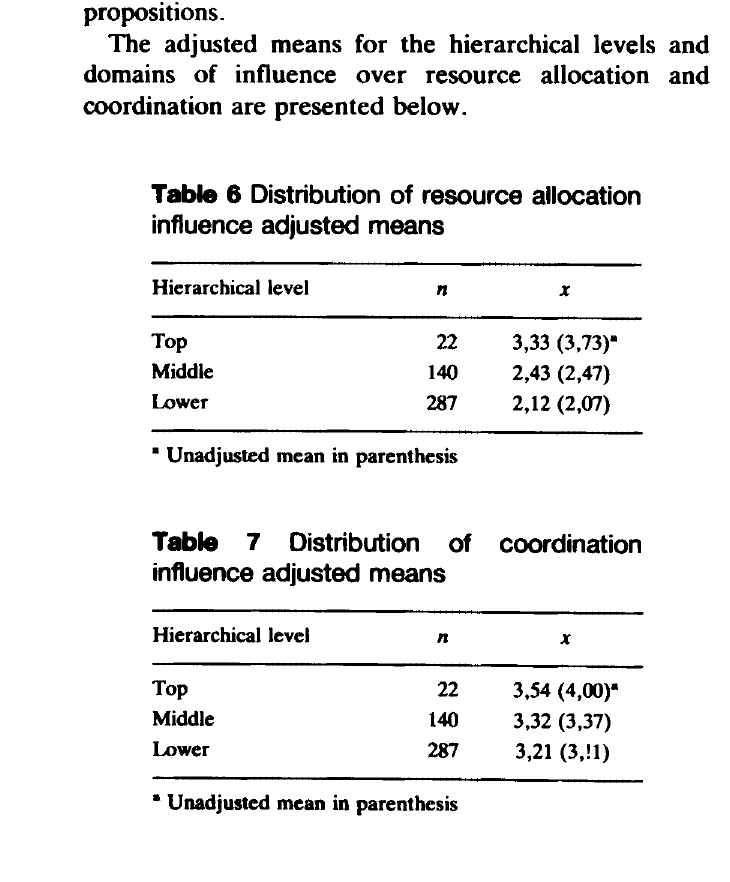
Table 6 Distribution of resource allocation